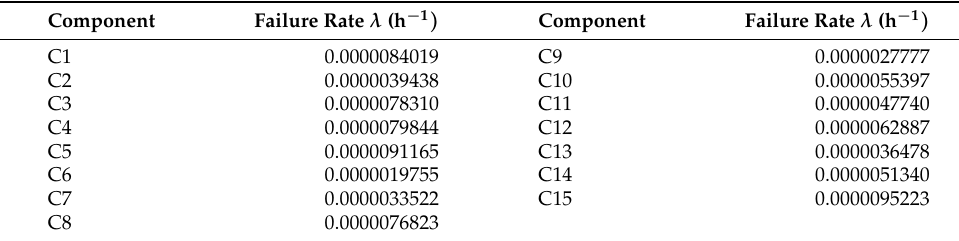
Table 1. Components and their respective failure rate λ .